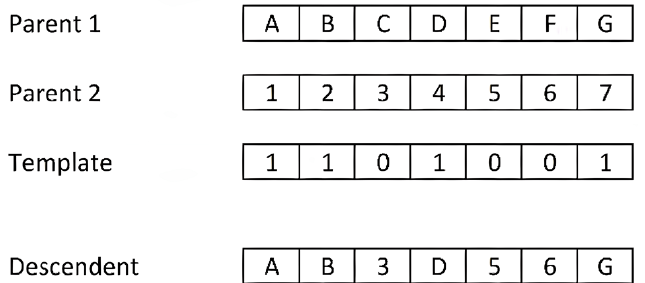
Figure 19. Example of the uniform crossover operation in a genetic algorithm. The descendant chromosome is assembled by taking genes from either parent as indicated by the binary mask.